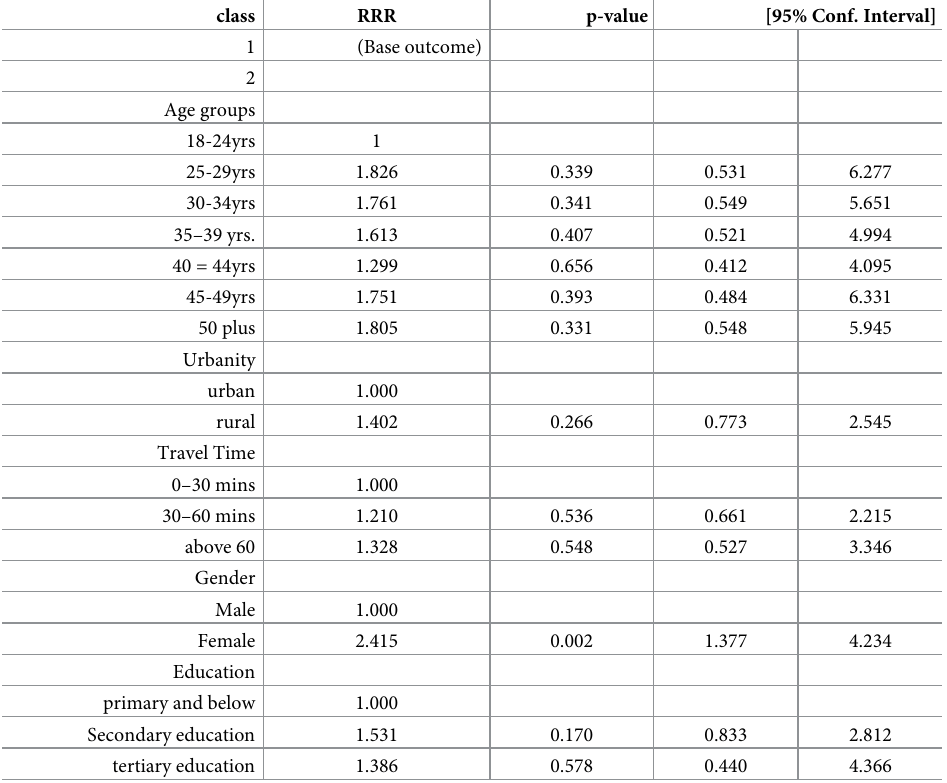
Table 6. Latent class membership predictors reporting relative-risk